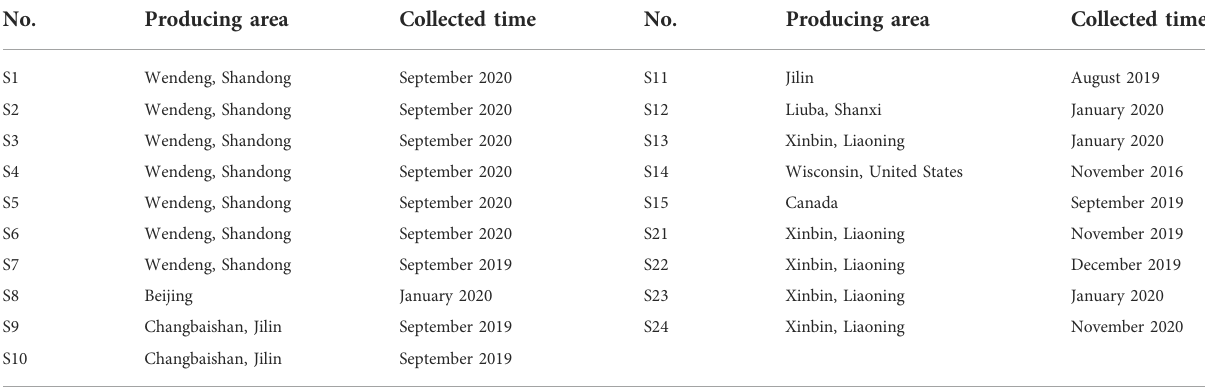
TABLE 1 Collection information of AG